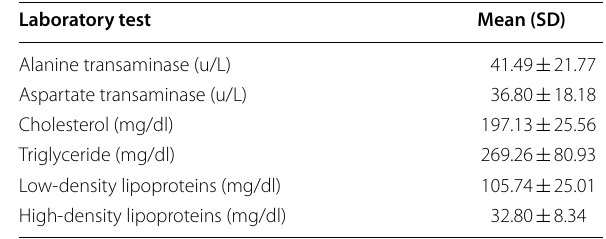
Table 1 Demographic data of enrolled patients ( N Demographic data